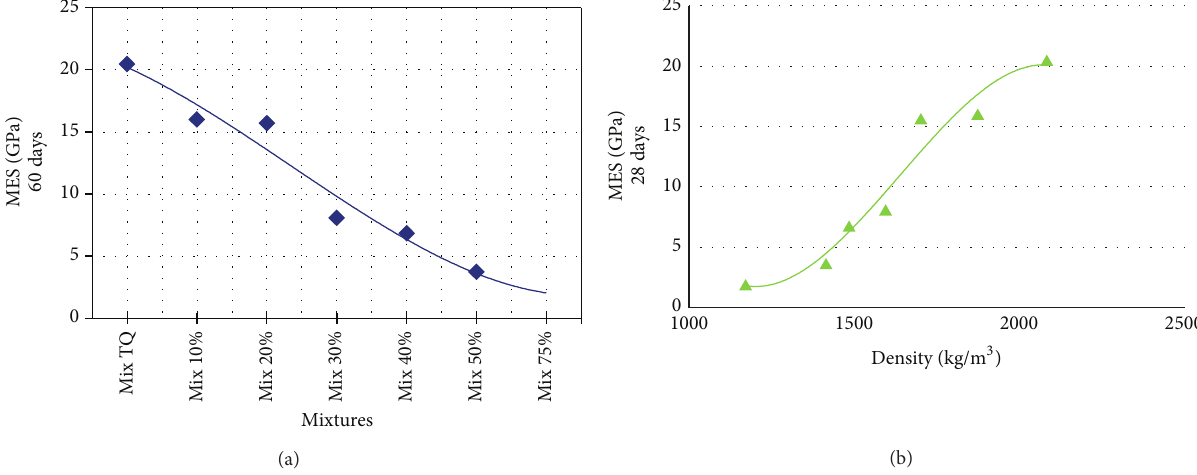
Figure 10: (a) MES of rubber cement composites on day 60; (b) MES on day 28 against density.